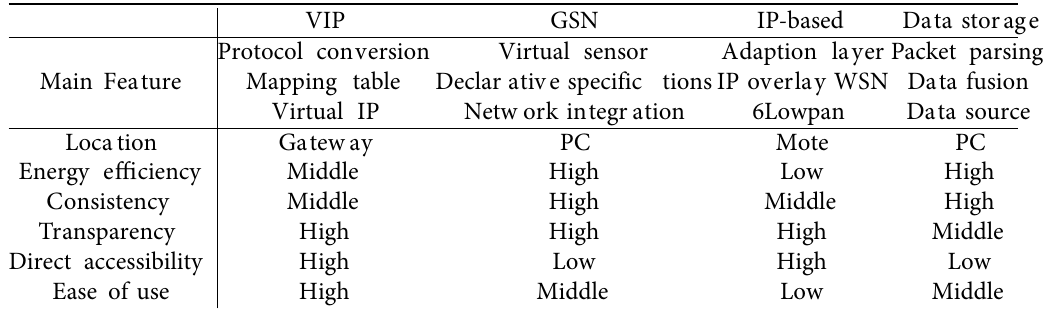
Table 2. Comparison of the Middleware solutions